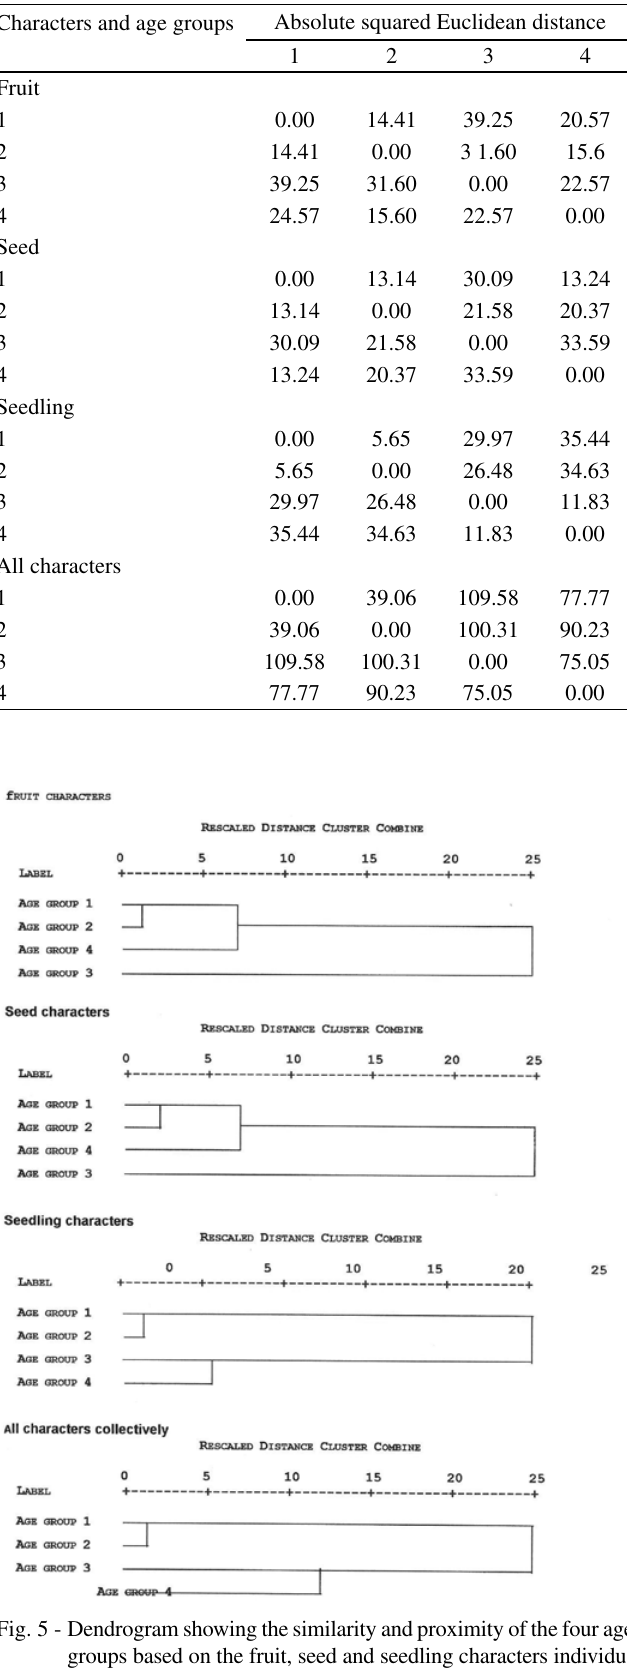
Table 5 - Proximity matrix showing the absolute squared Euclidean dis- tance between four age groups based on fruit, seed, seedling characters separately and collectively in mangosteen ( Gar- cinia mangostana L.)